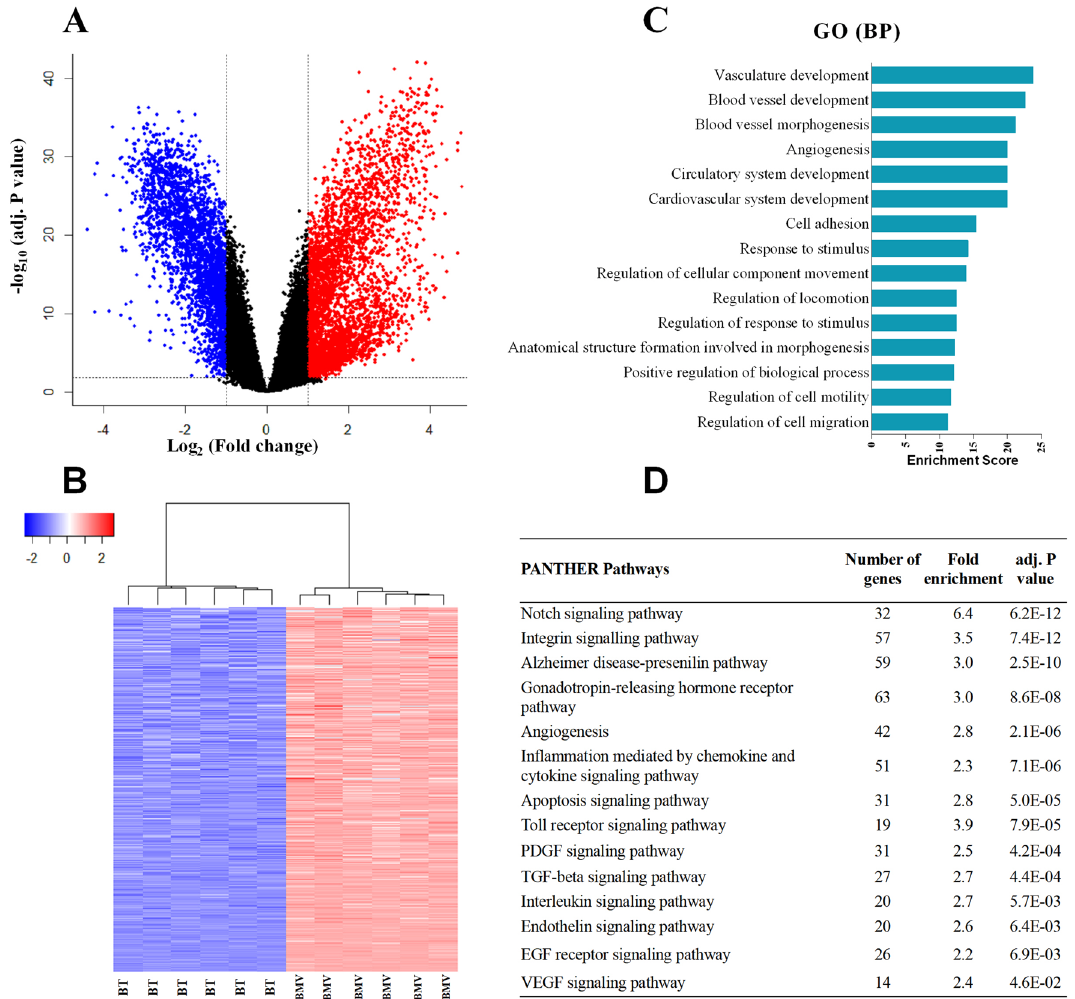
Figure 3. Gene expression comparison between brain microvessels (BMVs) and brain tissue (BT) in rats (n = 6). (A) Volcano plot for the BMVs versus BT whole transcriptomes. The red dots indicate the genes that are significantly higher expressed (fold change [FC] ≥ 2.0 and adjusted p < 0.05) in BMVs compared to BT, while blue dots indicate the lower expressed genes (FC ≤ -2.0 and adjusted p < 0.05) in BMVs. (B) Hierarchical cluster analysis for genes that are significantly enriched (FC > 2.0 and adjusted p < 0.05) in BMVs. (C,D) Top 15 gene ontology (GO) biological processes (BP) and 12 PANTHER pathways identified from the BMVs enriched genes. All the biological processes shown are ranked by enrichment score with a Bonferroni adjusted p <